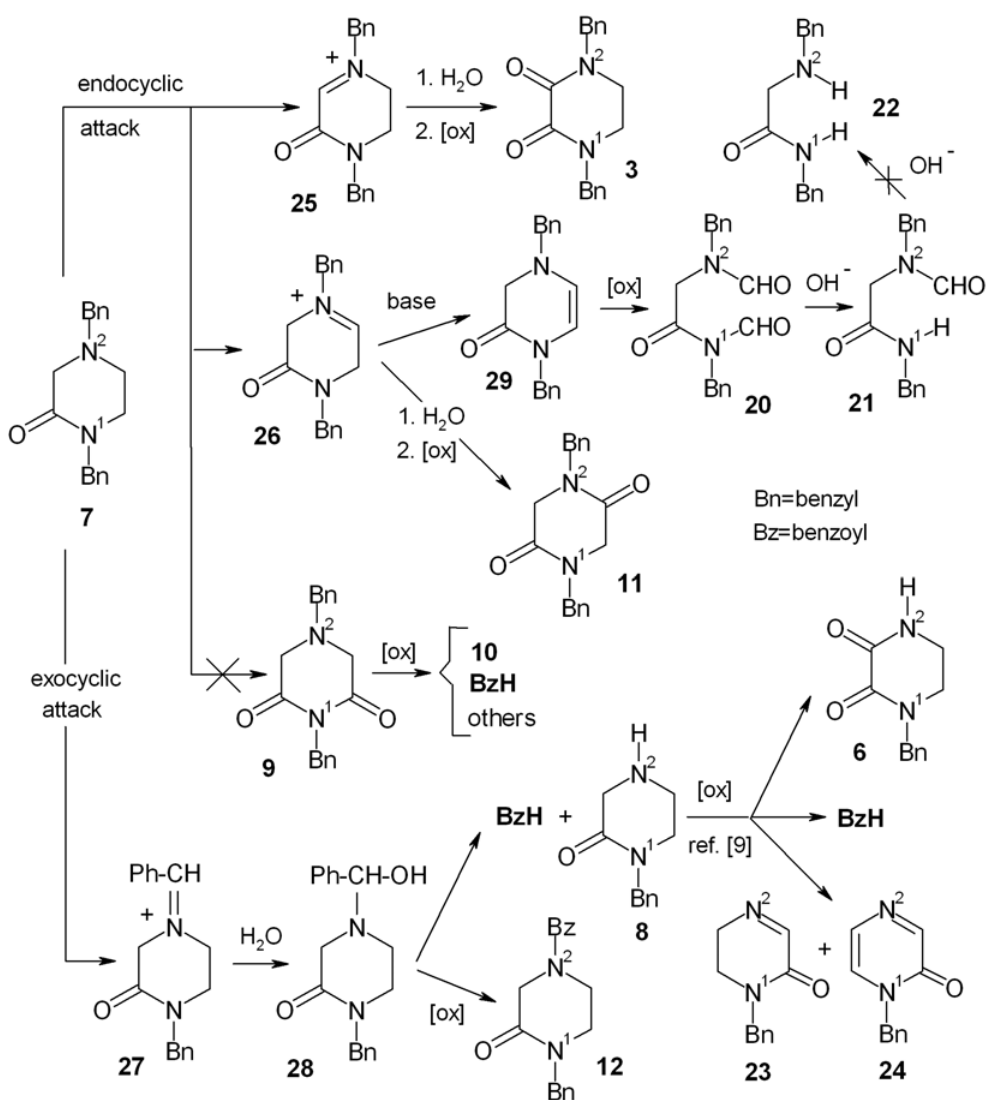
Scheme 3 Oxidation by RuO